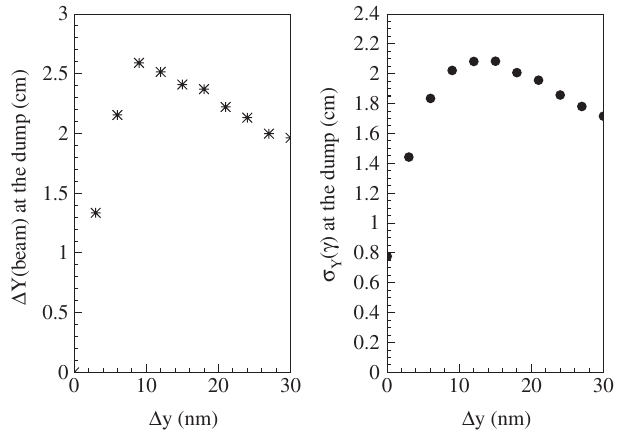
FIG. 26. Influence of a vertical position beam-beam offset on the position of the high-energy peak of the disrupted beam (left) and on the vertical size of the beamstrahlung photon cone (right).